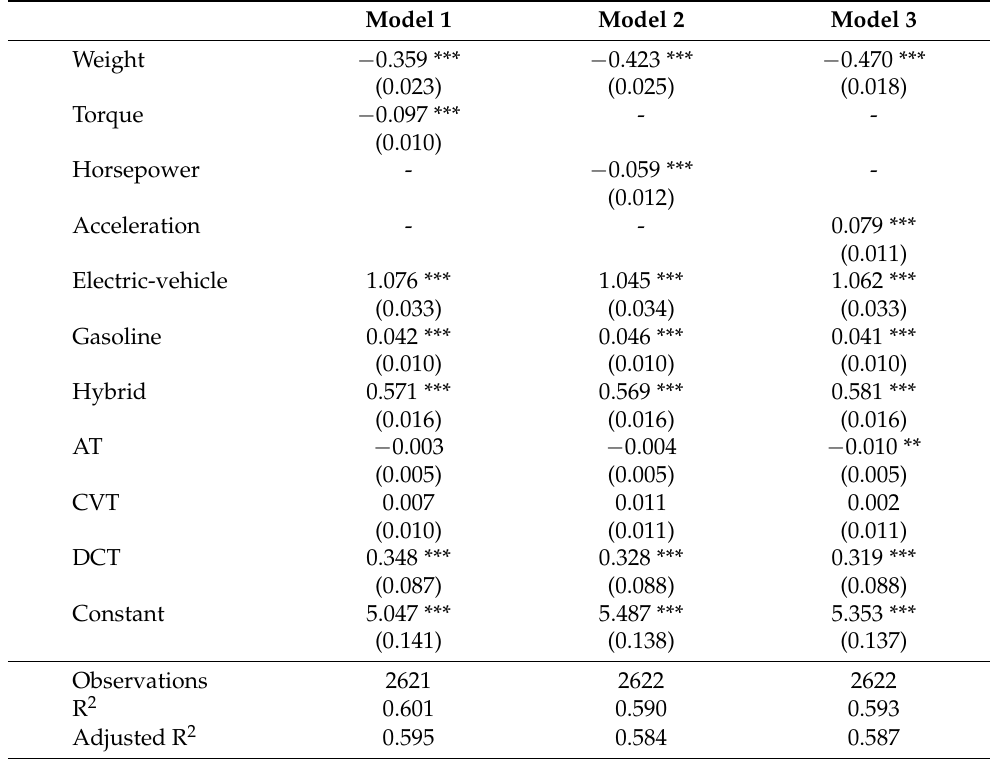
Table 1. Regression results for FE, where models 1, 2, and 3 indicate the elasticity of each explanatory variable, bearing in mind that torque, horsepower, and acceleration are linearly